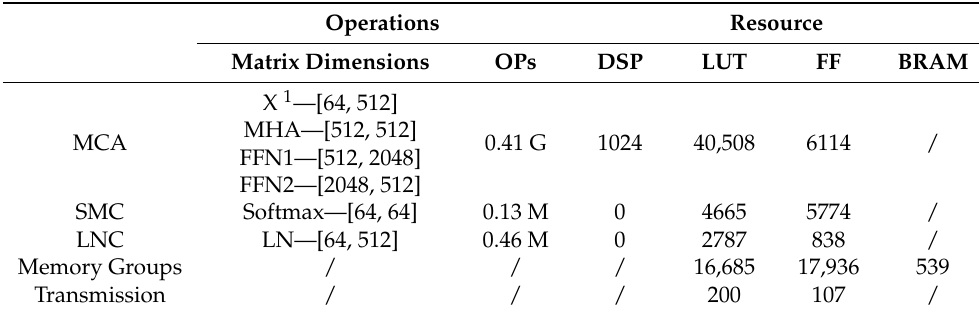
Table 3. The Operations and Resource Utilization of Submodules in Acceleration Architecture. Operations Resource Matrix Dimensions OPs DSP FF BRAM